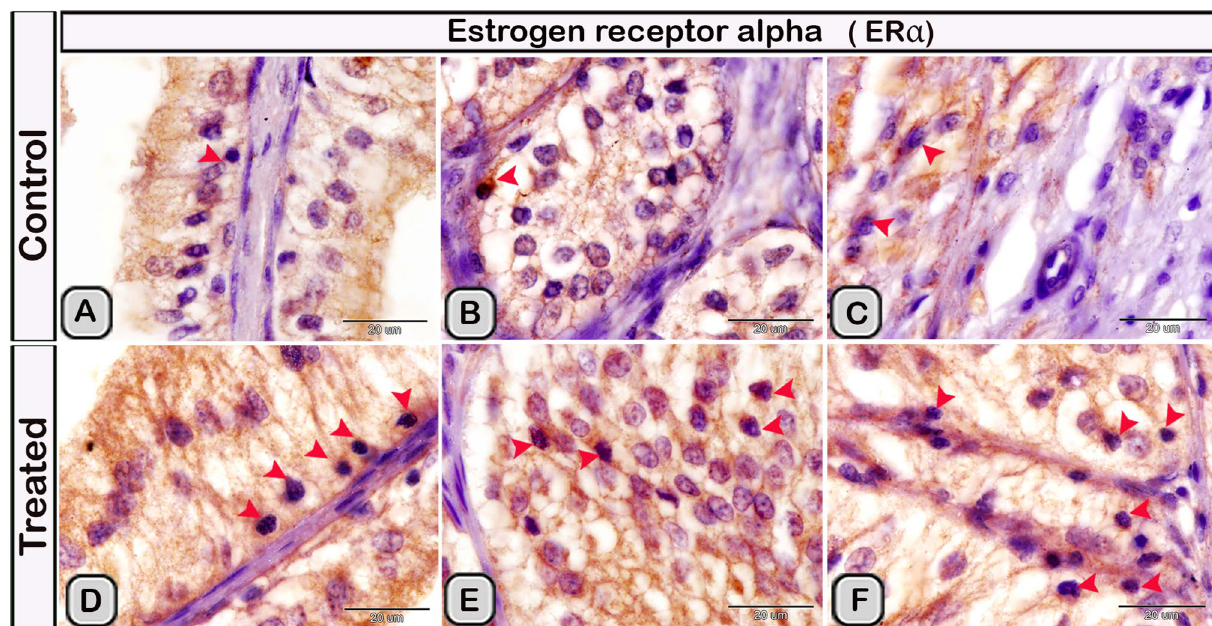
Figure 6. The effect of melatonin administration on the expression of estrogen alpha receptors in the dendritic cells (red arrowheads). (A,B) Expression of estrogen alpha receptor in the epithelium, (C) the expression in the interstitium of the control groups. (D,F) the expression of estrogen alpha receptor (ER-α) increased obviously in the melatonin treated groups.